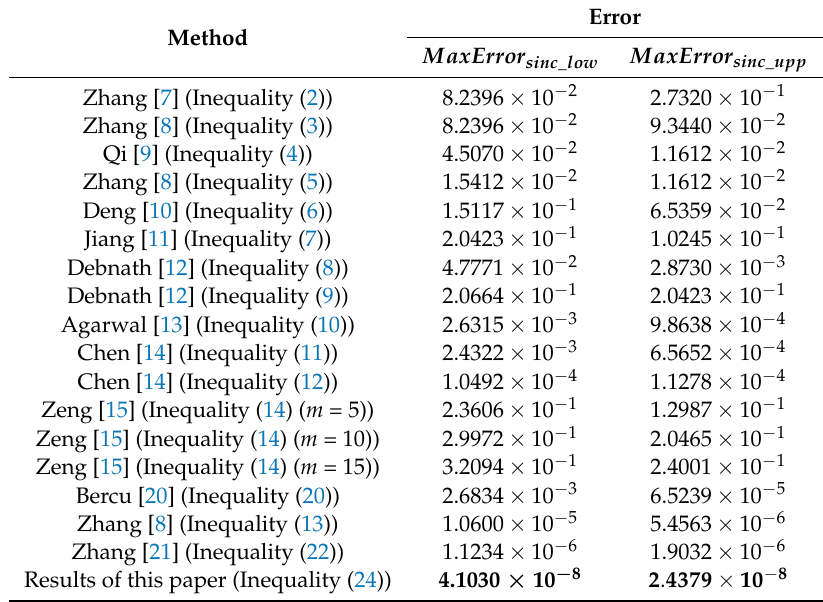
Table 1. Comparison of the maximum errors between sinc ( x ) and the bounds for different